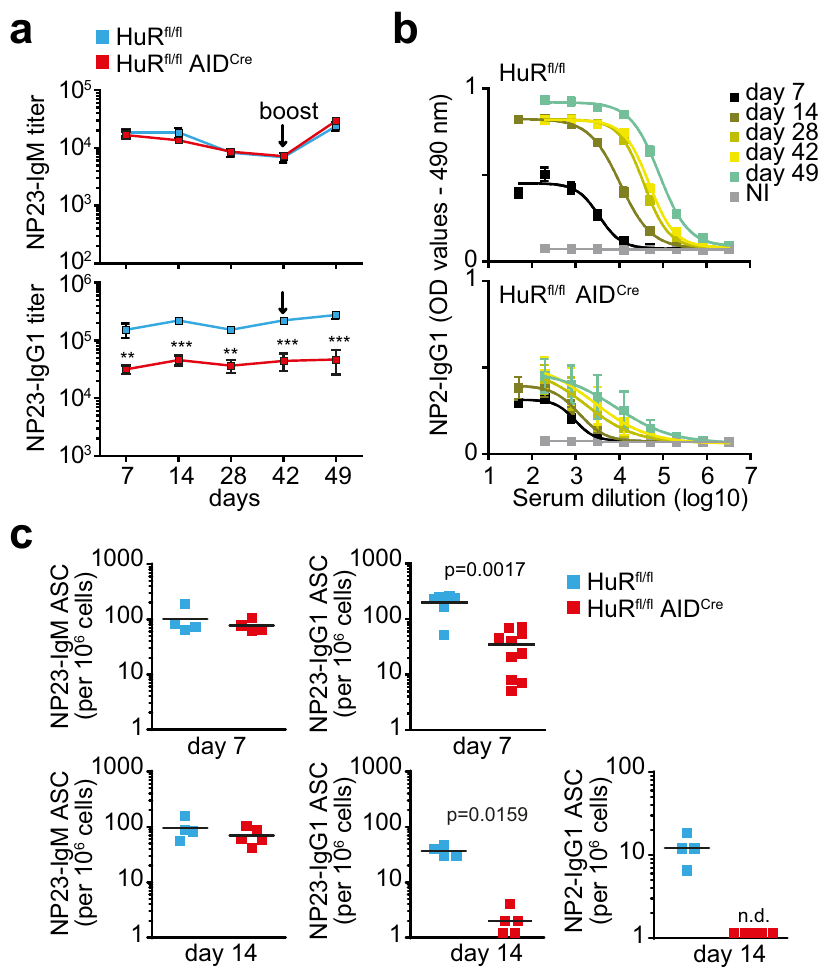
Fig. 1 Antibody responses are impaired upon deletion of HuR in GC B cells. a Serum titres of NP-IgM and NP-IgG1 from HuR fl / fl and HuR fl / fl AID Cre mice immunised with NP-KLH in alum (data shown as mean ± SD, n = 7 mice per group, two-way ANOVA and Bonferroni ’ s post-test, ** p < 0.01, *** p < 0.001). b Serum dilution curves for quantitation of high-af fi nity NP2-IgG1 in blood serum from mice described in a (data shown as mean ± SD, NI = not immunised). c Numbers of NP23-IgM, NP23-IgG1 and high-af fi nity NP2-IgG1-speci fi c antibody-secreting cells (ASCs) in the spleens of HuR fl / fl and HuR fl / fl AID Cre mice at day 7 and day 14 after immunisation (representative data from 1 of 3 independent experiments, n = 4 – 9 mice per group per experiment, two-sided Mann – Whitney test). Source data are provided as a Source data fi